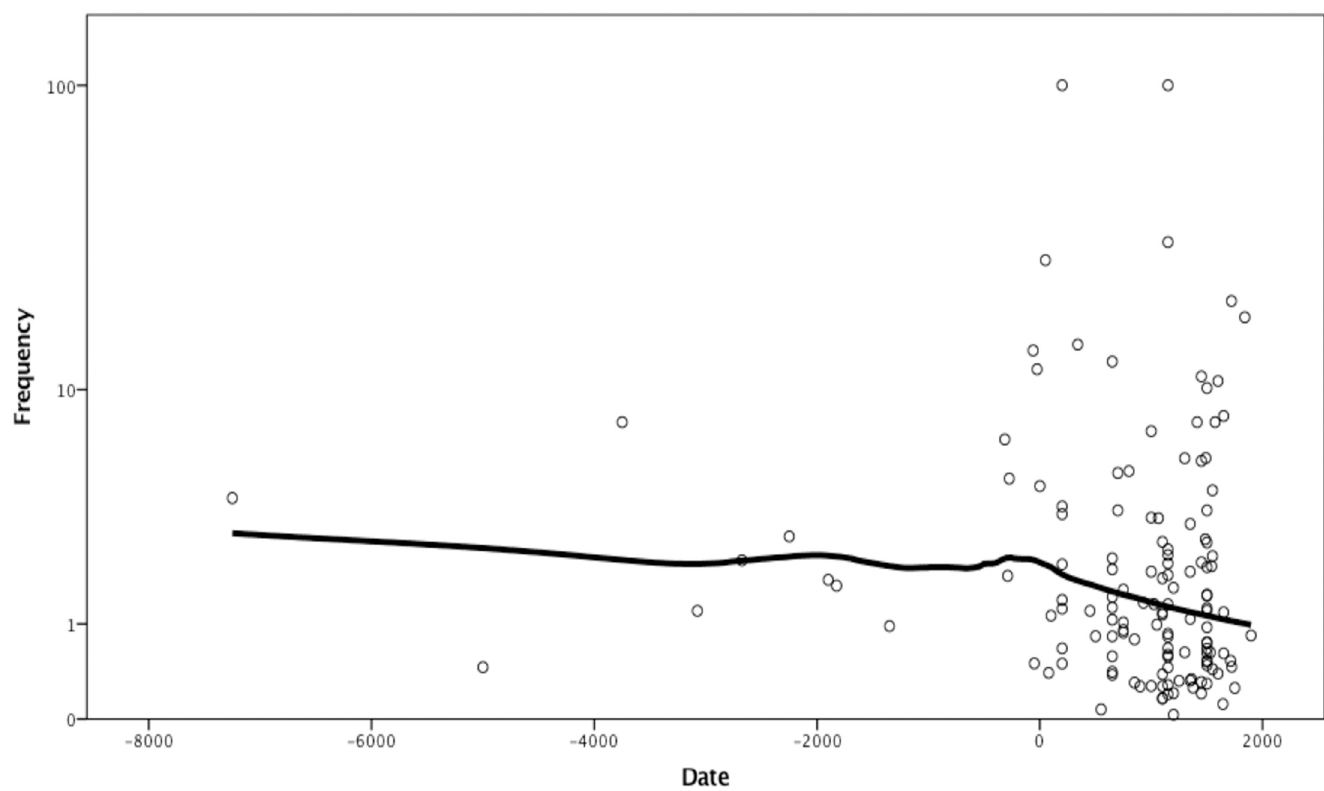
Fig 1. Logarithmed frequency of skeletal signs of tuberculosis by date. LOESS curve fitted with 95% of points included and tricube kernel.